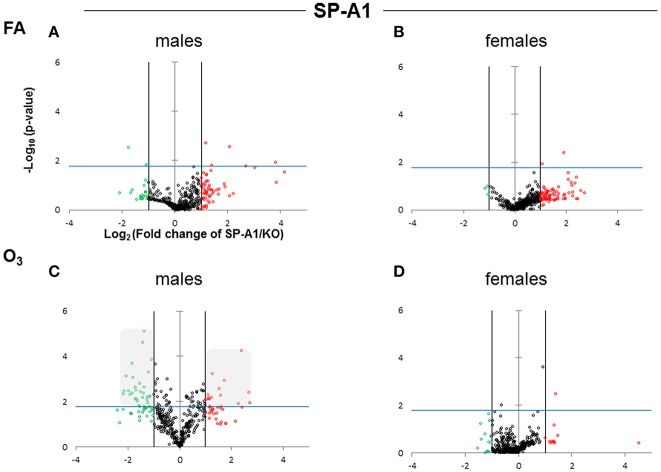
Volcano plots indicating the statistical significance of SP-A1 T2C miRNome expression levels compared to SP-A KO under FA or O3 exposure for males and females. The x-axis plots the log2 of the fold-changes, while the y-axis plots the –log10 of their p-values based on t-test of the replicate raw Ct data (section Materials and Methods). Each plot has three vertical lines. The middle vertical line that is graded corresponds to zero changes. The lines on either side represent ≥2-fold differences. Dots in the volcano plots above the blue horizontal line identify fold-changes with statistical significance of at least the Bonferroni corrected p < 0.0166. The red and green dots represent miRNAs that were upregulated ≥2 fold and downregulated ≥2 fold, respectively, compared to KO. Black dots signify miRNAs that were regulated <2-fold times (i.e., x ≤ 2, x is the fold change). (A) Male SP-A1 mice compared to KO exposed to FA; (B) Female SP-A1 mice compared to KO exposed to FA; (C) Male SP-A1 mice compared to KO after O3 exposure; (D) Female SP-A1 mice compared to KO after O3 exposure. The shaded gray area in (C) shows show the differences in the miRNAs that are highly and significantly regulated.